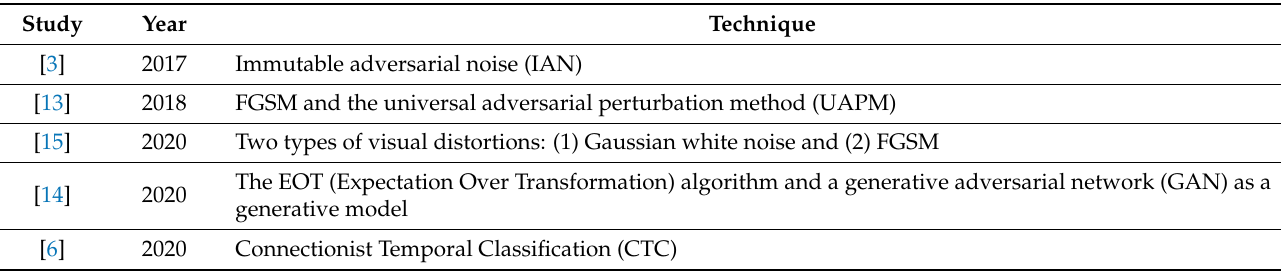
Table 5. Summarizing the used techniques for generating adversarial